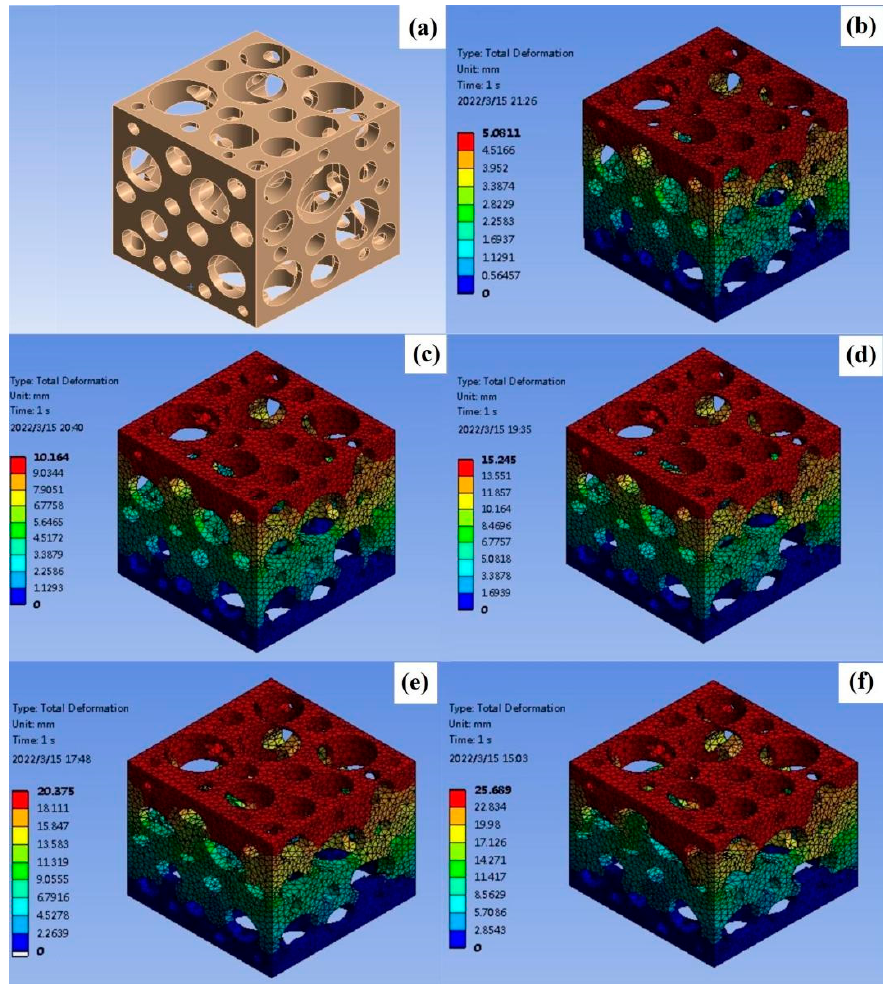
Figure 6. Deformation of sponge with different displacement constraints: ( a ) no deformation, ( b ) 5%, ( c ) 10%, ( d ) 15%, ( e ) 20%, and ( f ) 25%.